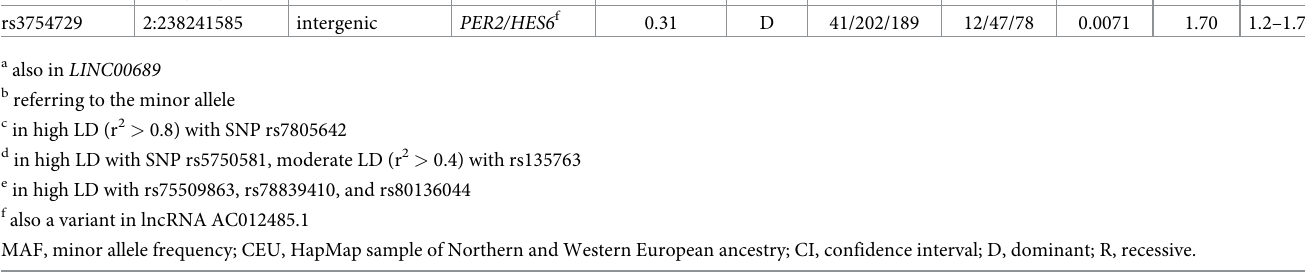
of control samples with the combined genotype A/A for rs4128839 (homozygotes for the major allele) and T/T+C/T for rs80136044 (at least one copy of the minor allele) compared to the OUD samples, 0.01 vs. 0.13, respectively) (S1 Table). Notably, the minor T allele of PER2 rs80136044 was associated with the risk of OUD in the single gene analysis under the domi- nant model, but there was no significant association of SNP rs4128839 in the single SNP analysis.